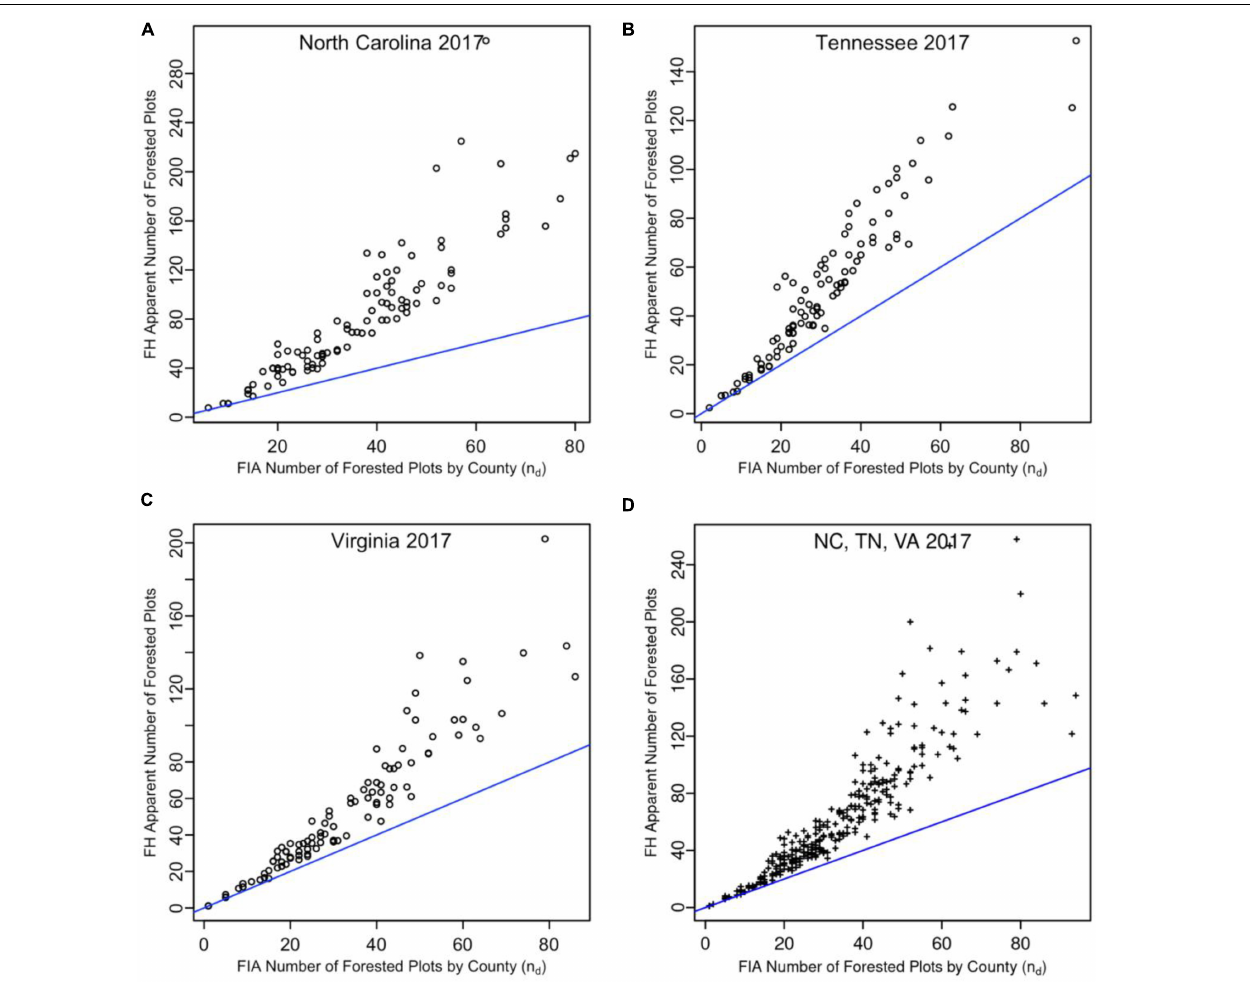
FIGURE 3 | Apparent domain sample sizes ( n d , app ) for total forest volume of study area counties compared to FIA sample sizes from direct estimates. Non-spatial FH estimators were used for results shown in panel (A–C) , while the SFH estimator was used for panel (D) .